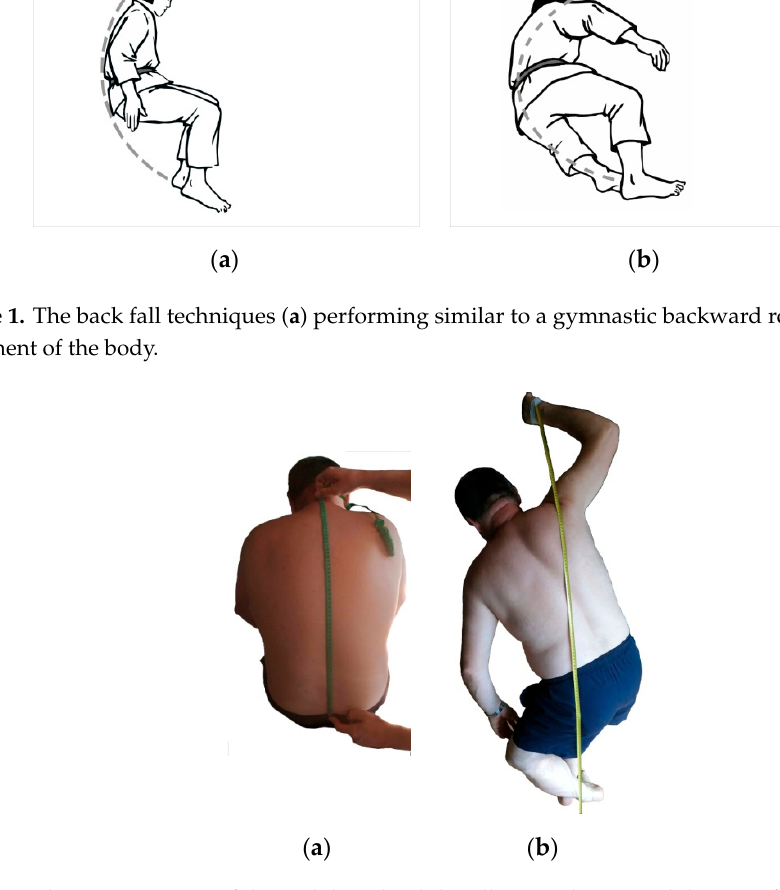
Figure 2. The measurement of the path length while rolling on the ground during a fall, for the same person ( a ) performed in a way similar to gymnastic backward roll ( b ) with side alignment of the body.